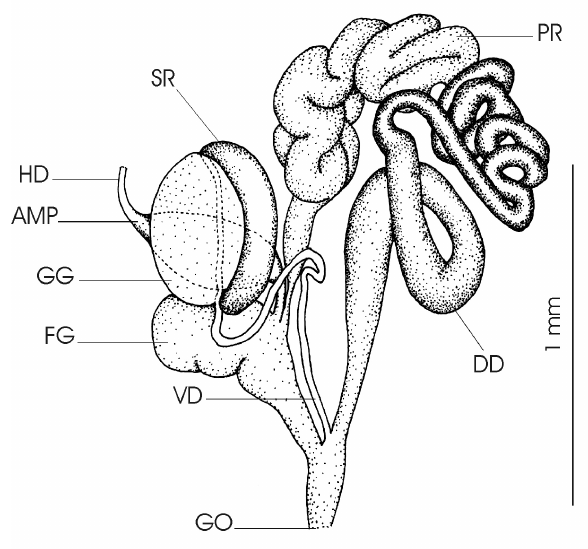
red line and there is a yellow line within it. Scattered on the dorsum are small red marks which are not aligned in longitudinal rows. There is no longitudinal stripe over the tail and the gills are red with white bases, while C. paulomarcioi n. sp. have completely reddish or pink anterior branchia.